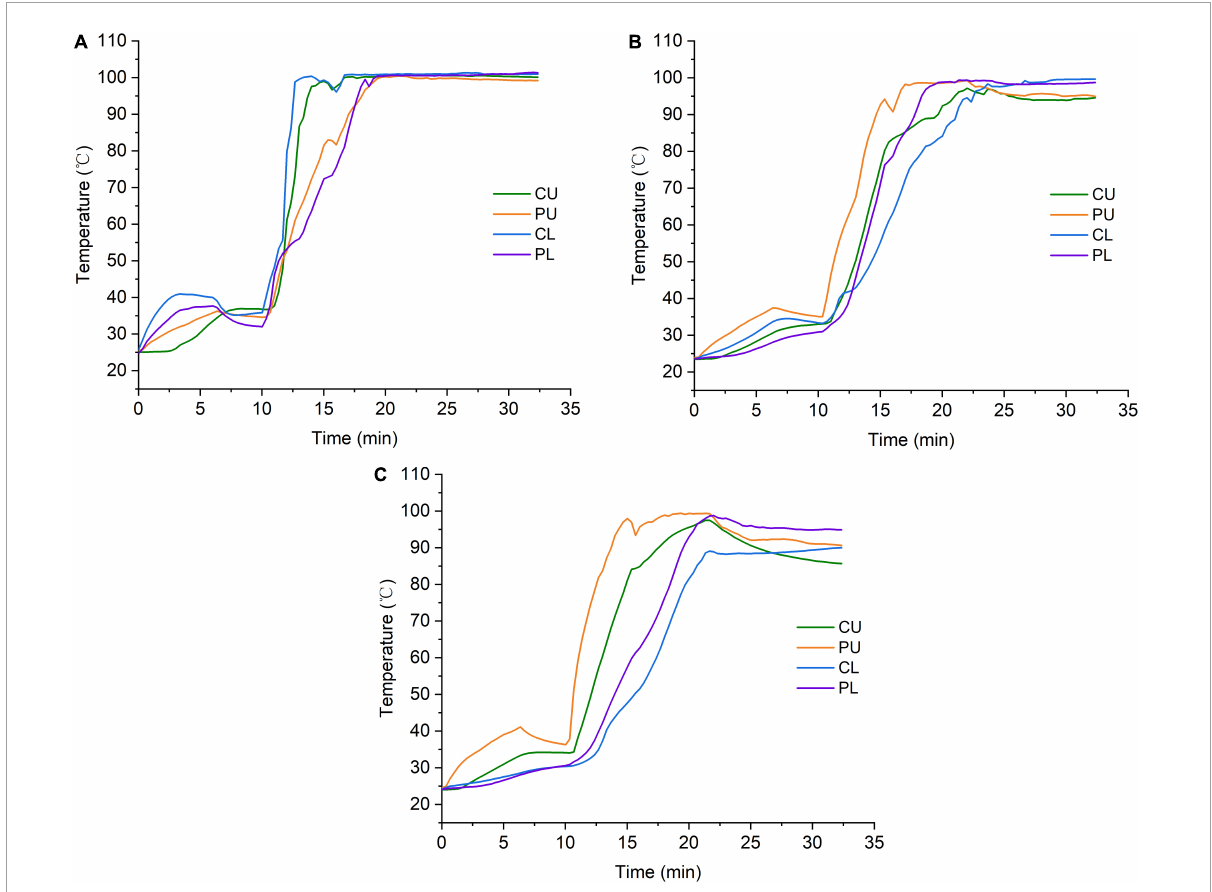
FIGURE2 Temperature distribution under different heating modes. (A) Mode 1. (B) Mode 2. (C) Mode 3. CU, central upper layer; PU, peripheral upper layer; CL, central lower layer; and PL, peripheral lower